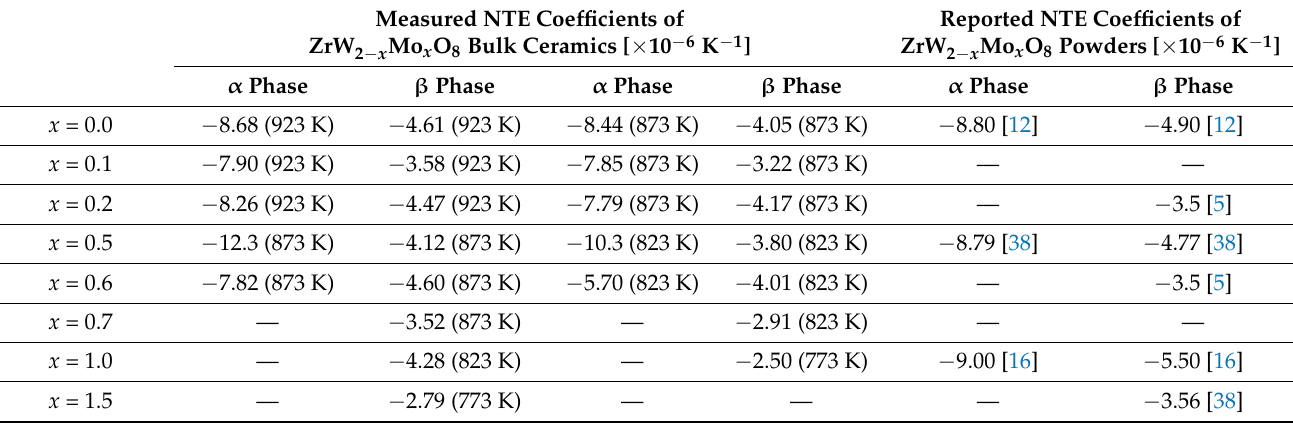
Table 1. NTE coefficients of cubic-ZrW 2 − x Mo x O 8 bulk ceramics by TMA. Measured NTE Coefficients